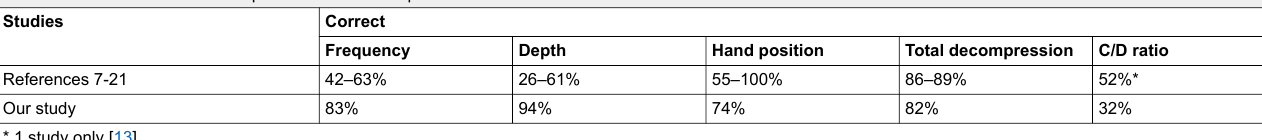
Table 6: Results of literature comparison of chest compression outcomes